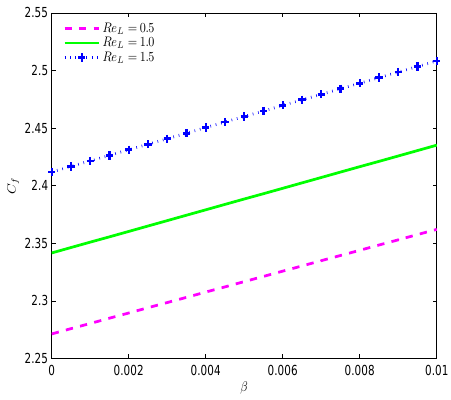
Fig. 14: Variation of C f with β for α = 0.001